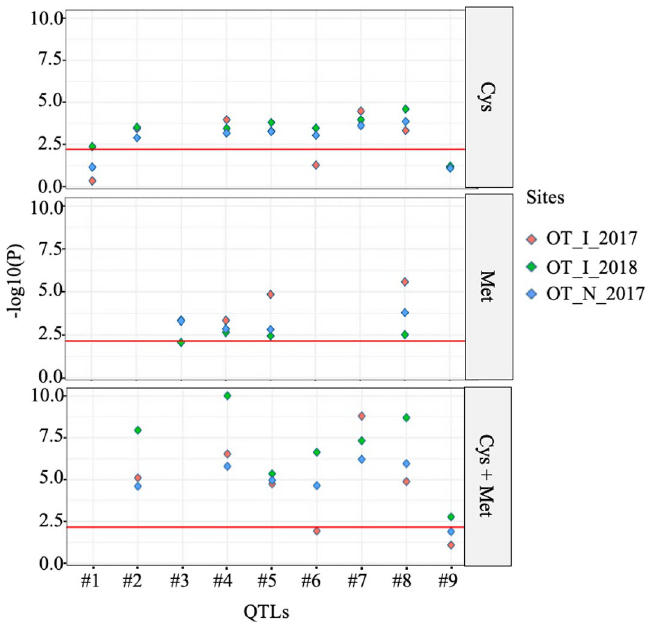
Figure 5. Degree of significance ( p -value) of the contrast between phenotypic means for lines carrying different alleles at candidate QTLs for sulfur-containing amino acid content in whole soybean seeds. Cys, Met, and Cys + Met content was measured in a core set of 137 Canadian soybean accessions in three environments (indicated by coloured symbols). A t-test was performed to compare the mean trait value for lines sharing one or the other allele at the nine QTLs discovered in the MLM method. Each coloured symbol represents the p -value for this comparison of means. The red horizontal bar indicates the adjusted Bonferroni significance threshold